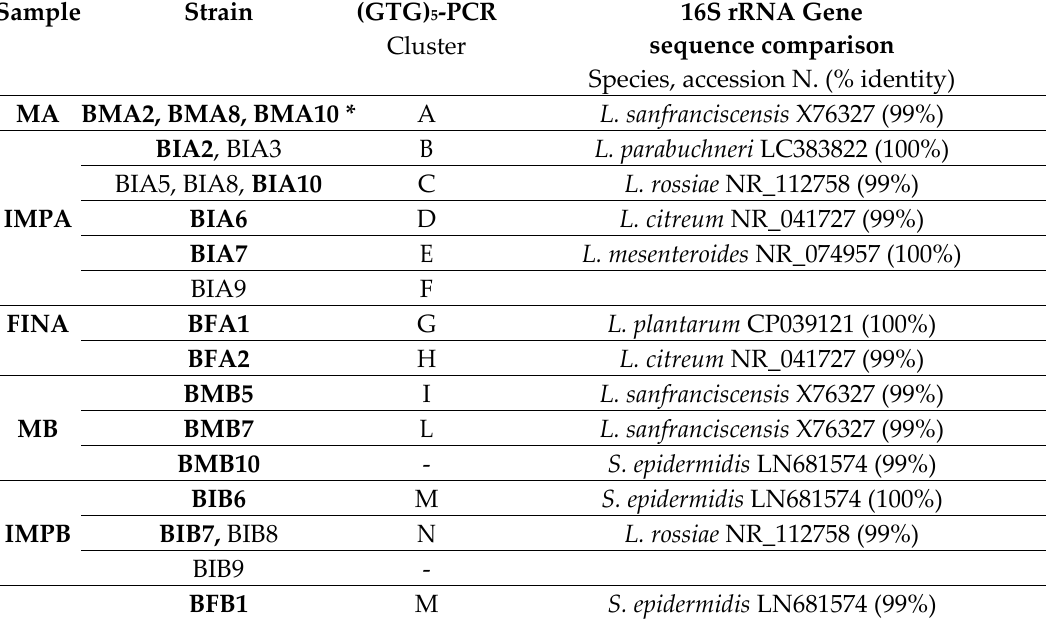
Table 2. (GTG) 5 -PCR cluster and sequencing of the 16S rRNA gene of the bacterial strains isolated from sourdough’s